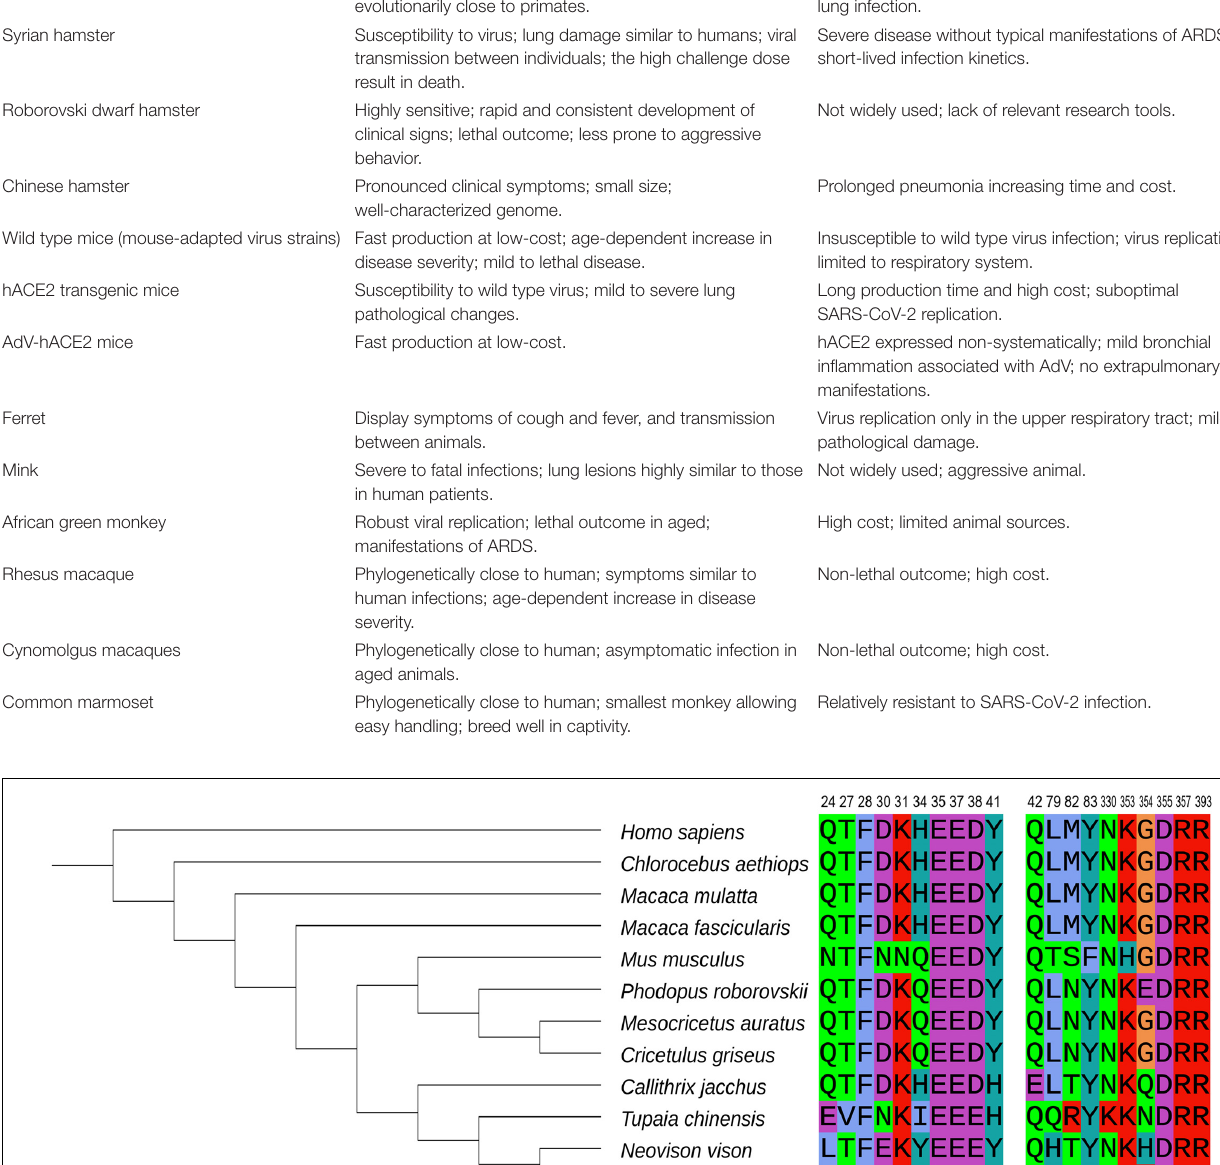
and v2163, which caused lung damage and death in